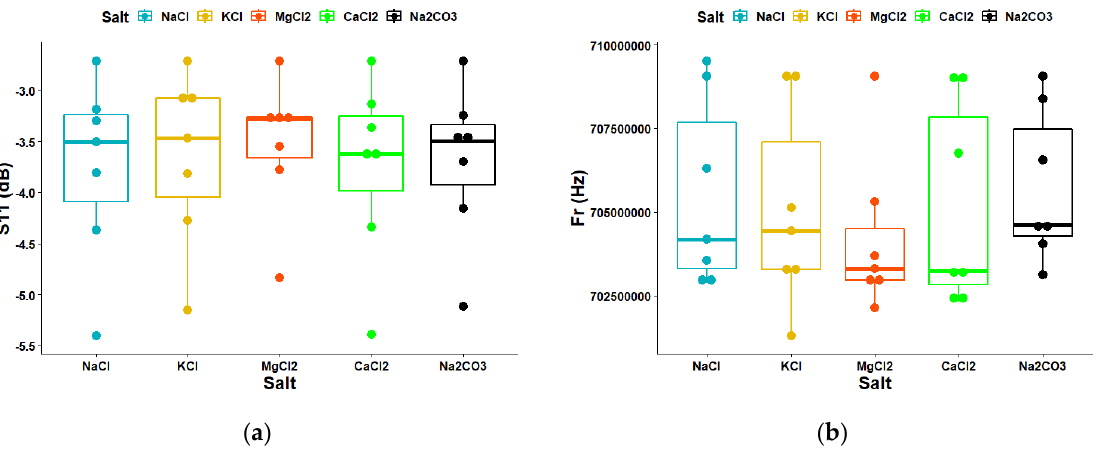
Figure 12. The distribution characteristics of the raw data were compared in each group obtained from the third resonance peak: ( a ) boxplot (S 11 ) and ( b ) boxplot (F r ).